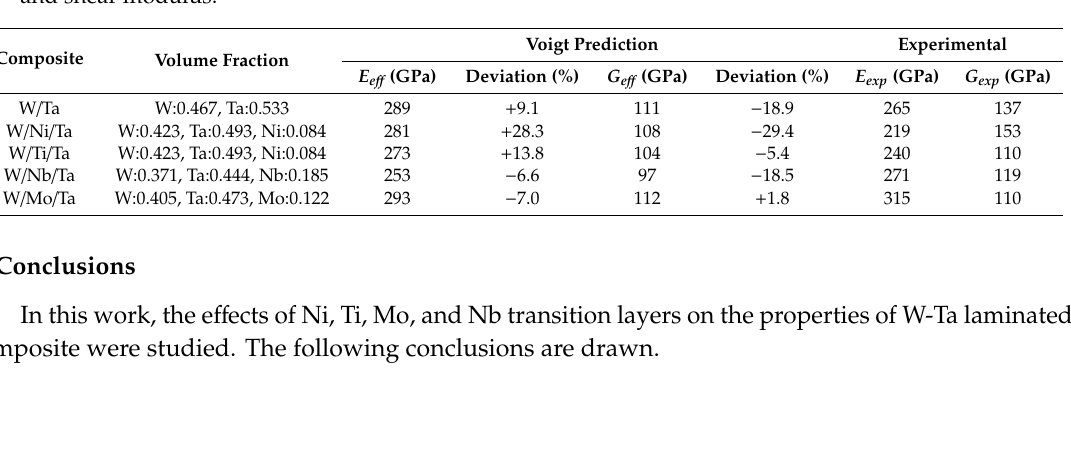
Table 5. The Voigt prediction E Vp , G Vp values and experimental E exp , G exp values of the Young modulus and shear